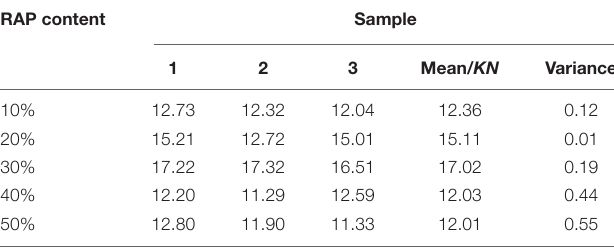
TABLE 6 | Result of the uniaxial compression